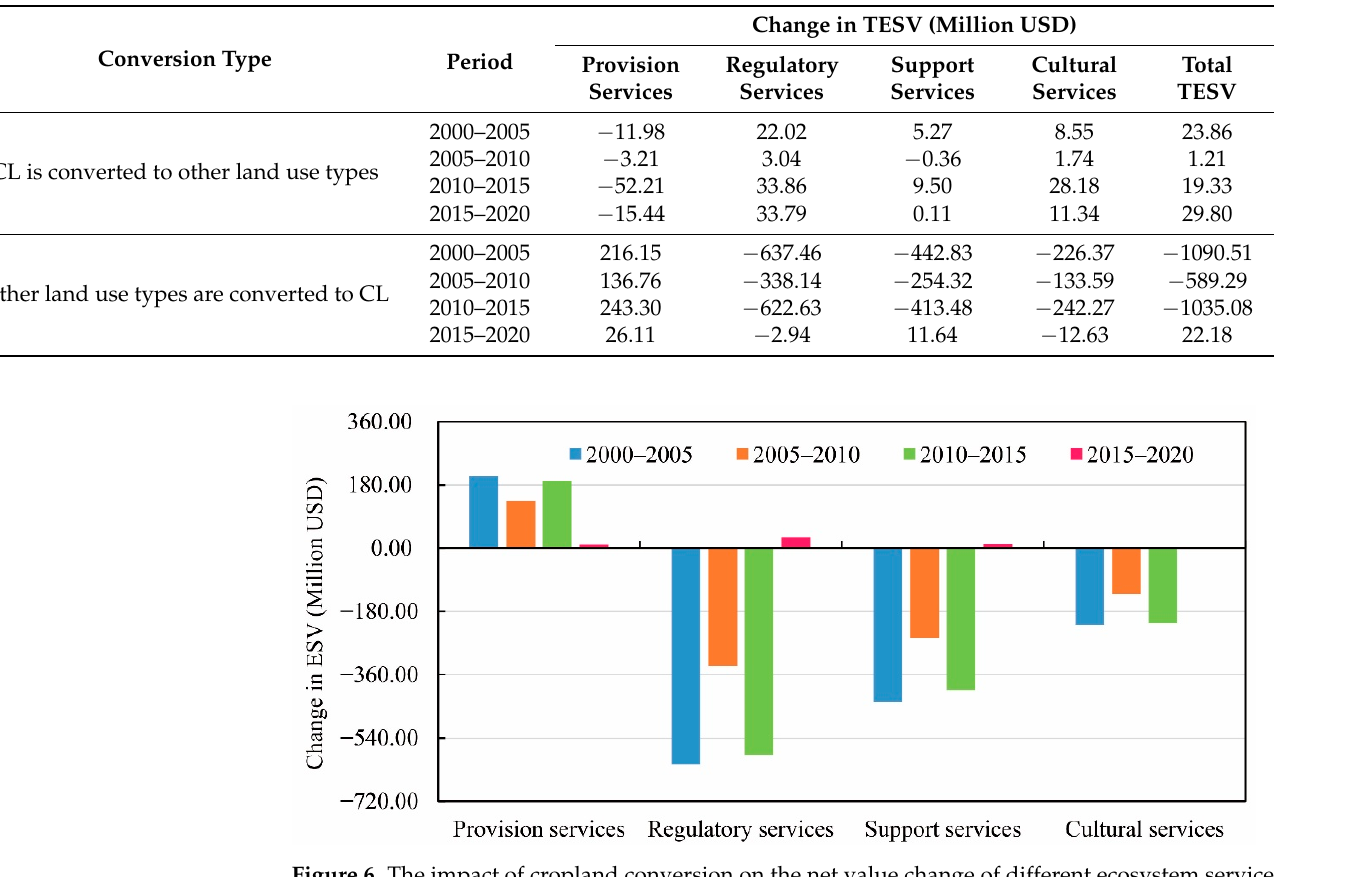
Figure 6. The impact of cropland conversion on the net value change of different ecosystem service types in Xinjiang during 2000–2020. Table 8. Changes in the TESV caused by the conversion of cropland in Xinjiang during 2000–2020.